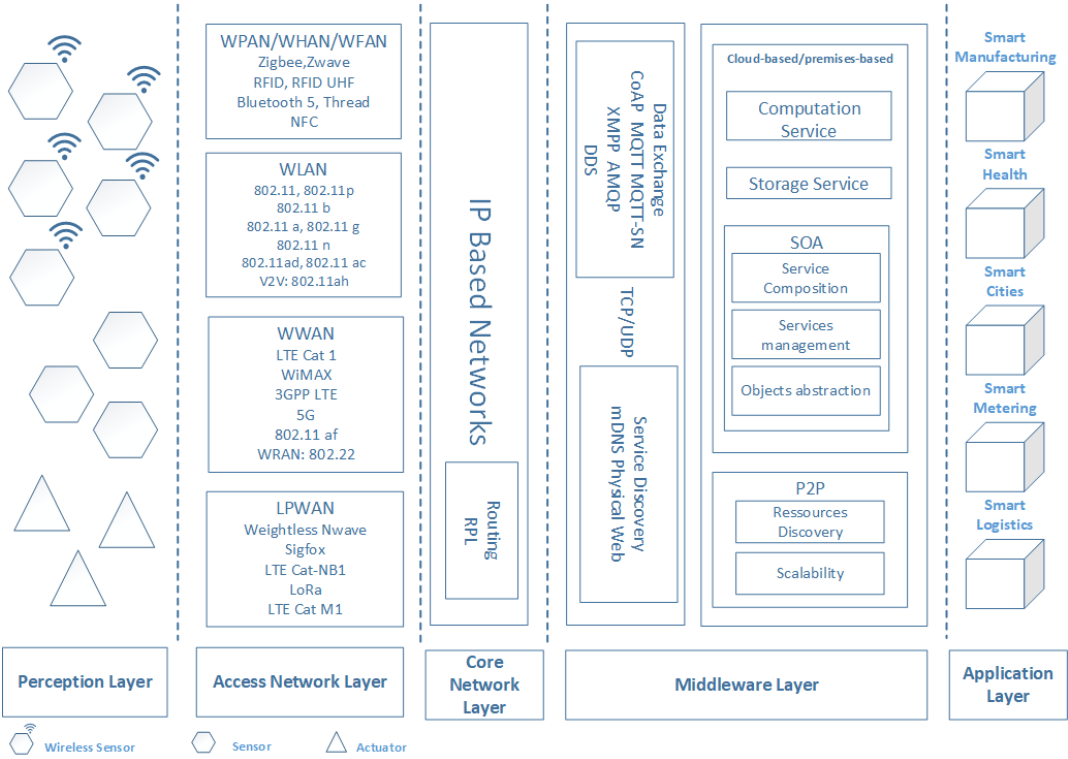
Figure 5. The layered architecture used for building the reliability framework of an End-to-End IoT system.